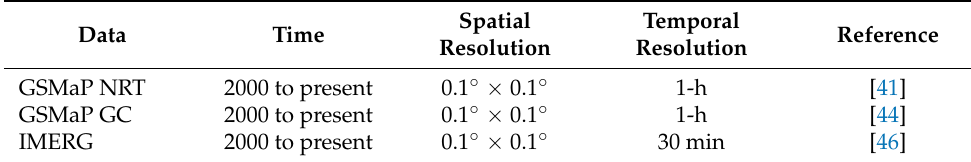
Table 2. Dataset list used in this